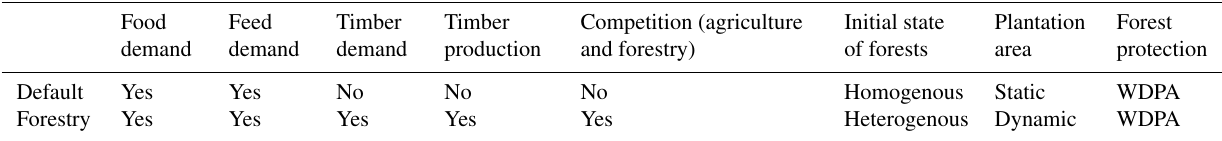
Table 1. Summary of main differences between the two scenario